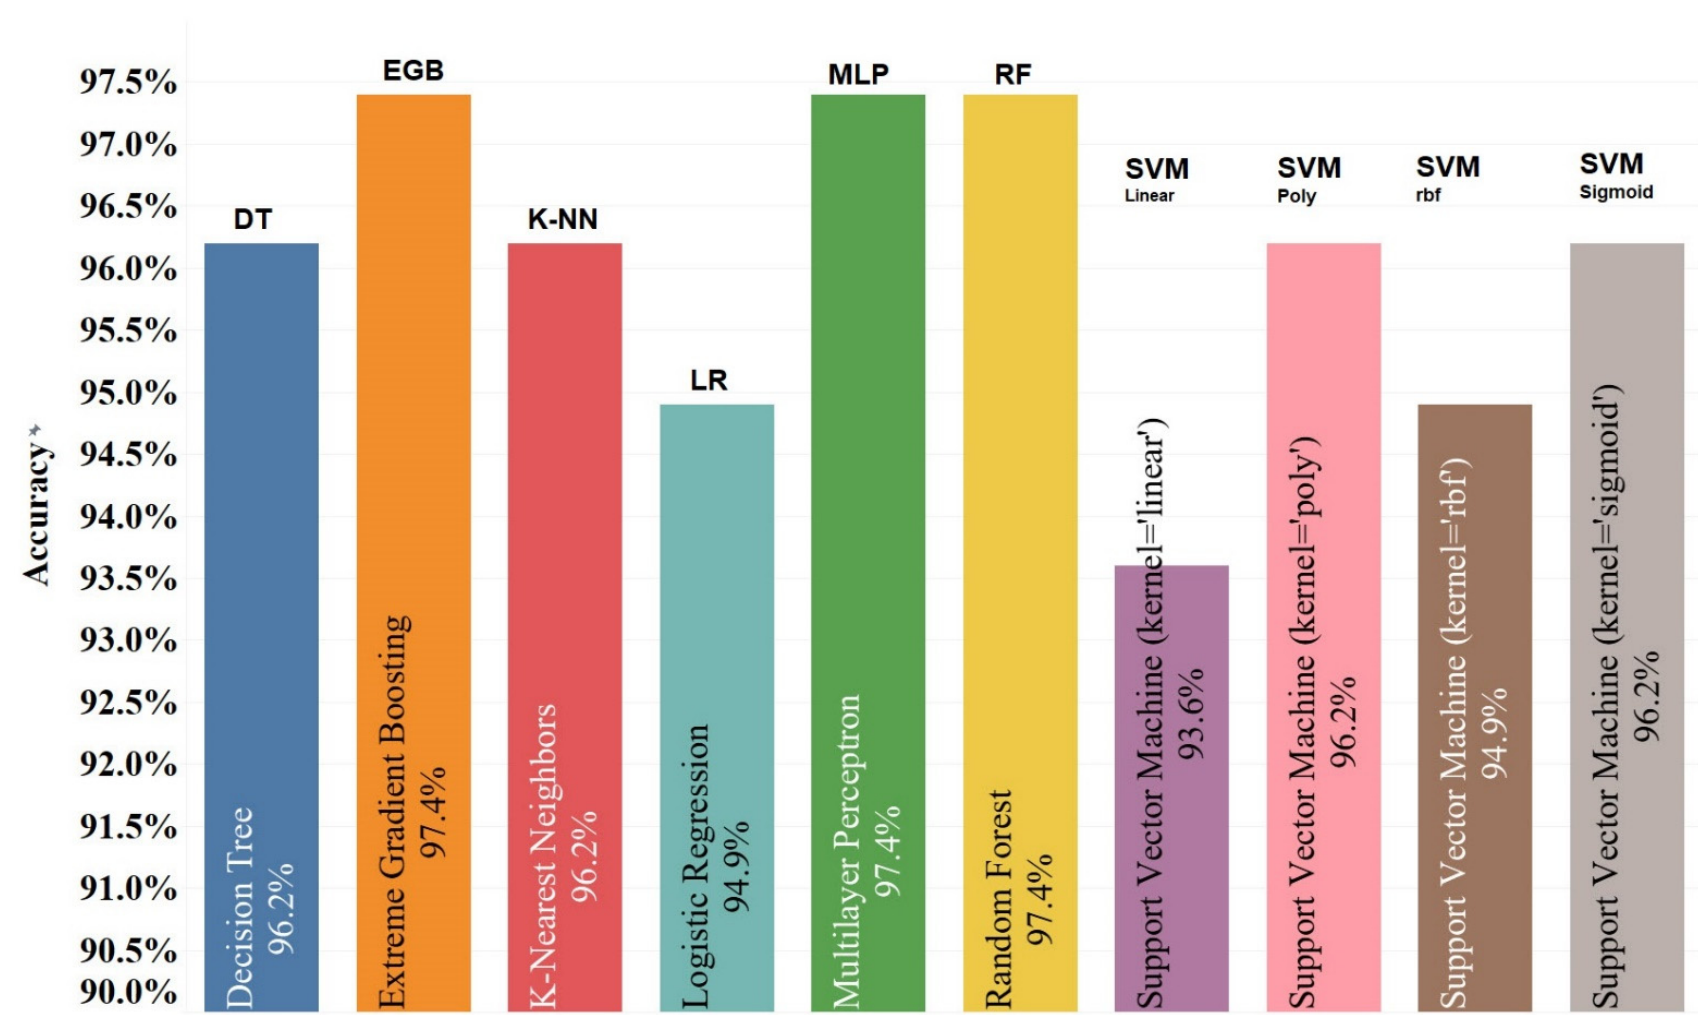
Figure 3. Accuracy of classifiers for 3 different types of risks with the Leave-One-Out Cross-Validation method.